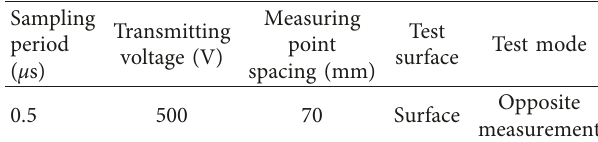
Table 1: Ultrasonic system parameter